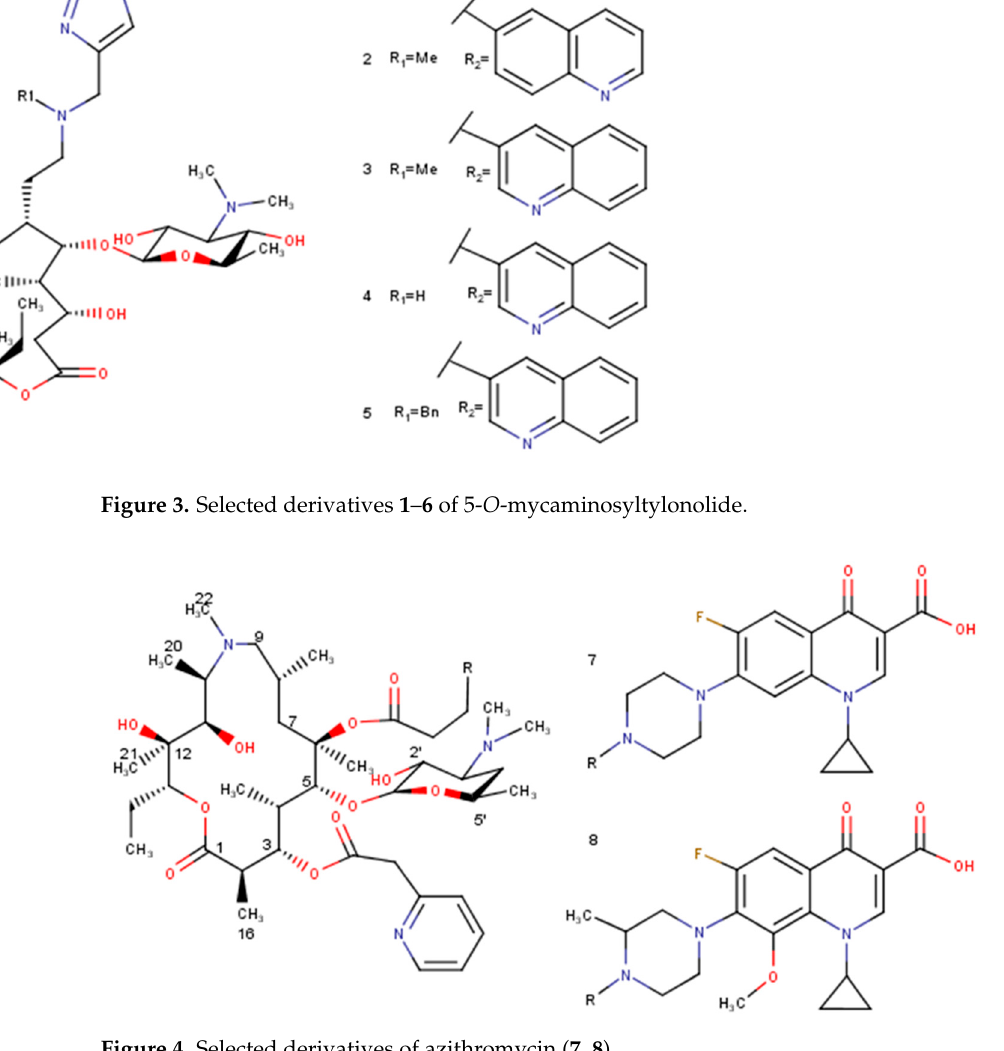
Figure 4. Selected derivatives of azithromycin ( 7 , 8 ).